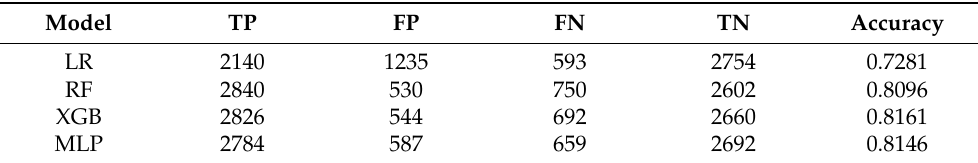
Table 3. Elements of the confusion metric for evaluating classification models’ performance assess- ments for four machine learning models.